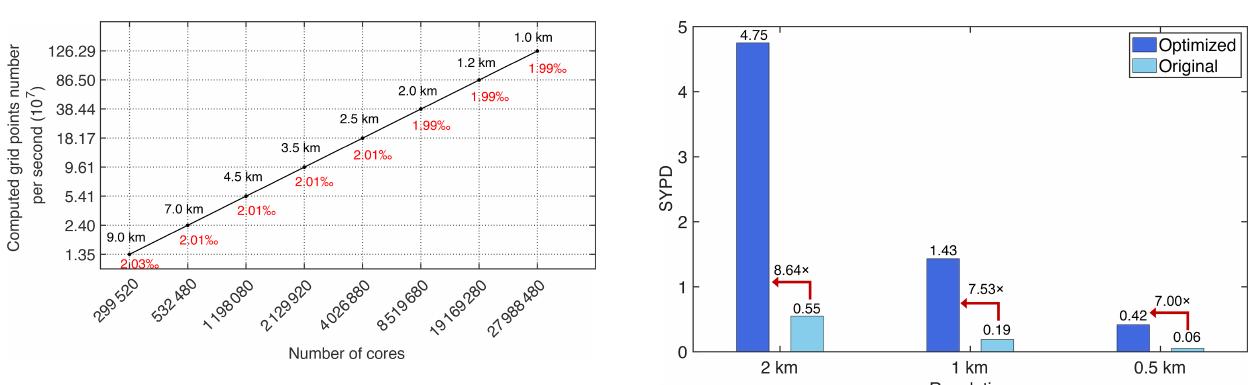
Figure 13. The weak-scalability results, scaling from 299520 to 27988480 cores with eight different resolutions.